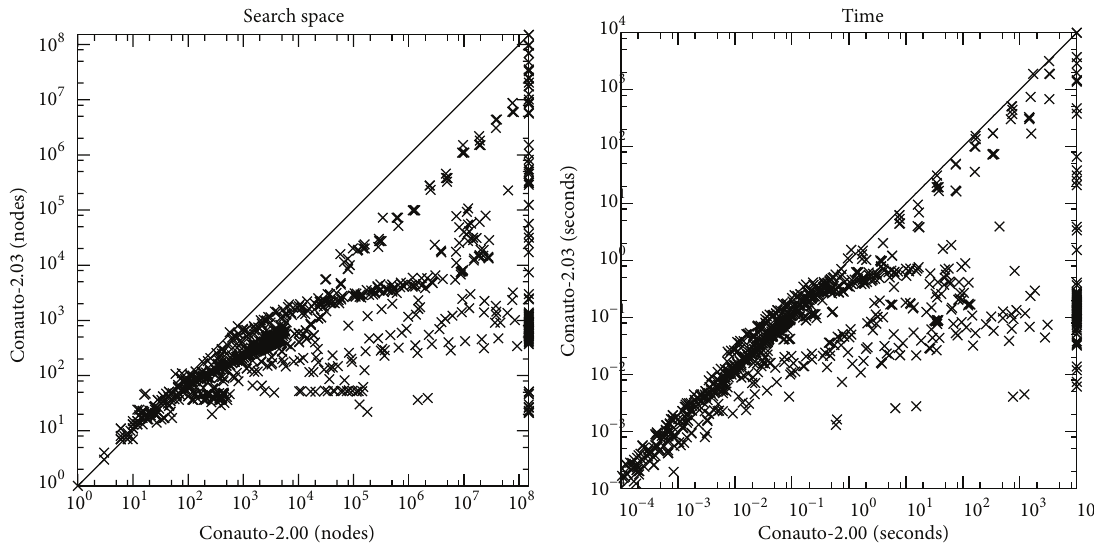
Figure 6: Conauto-2.00 versus conauto-2.03 search-space and running time